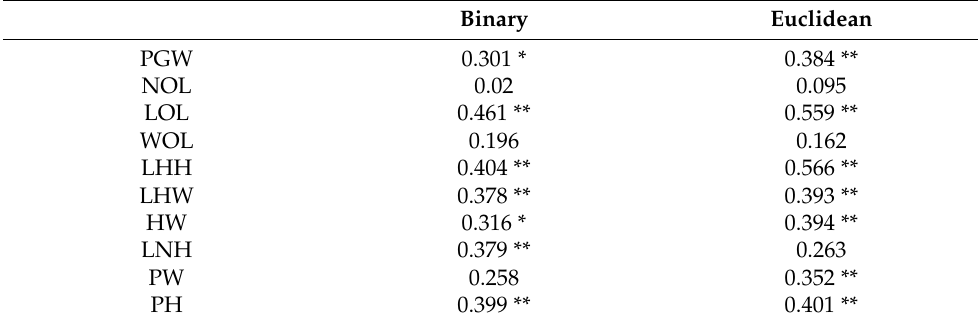
Table 6. Correlation between observed value of traits and parents’ genetic distance. Binary Euclidean PGW 0.301 * 0.384